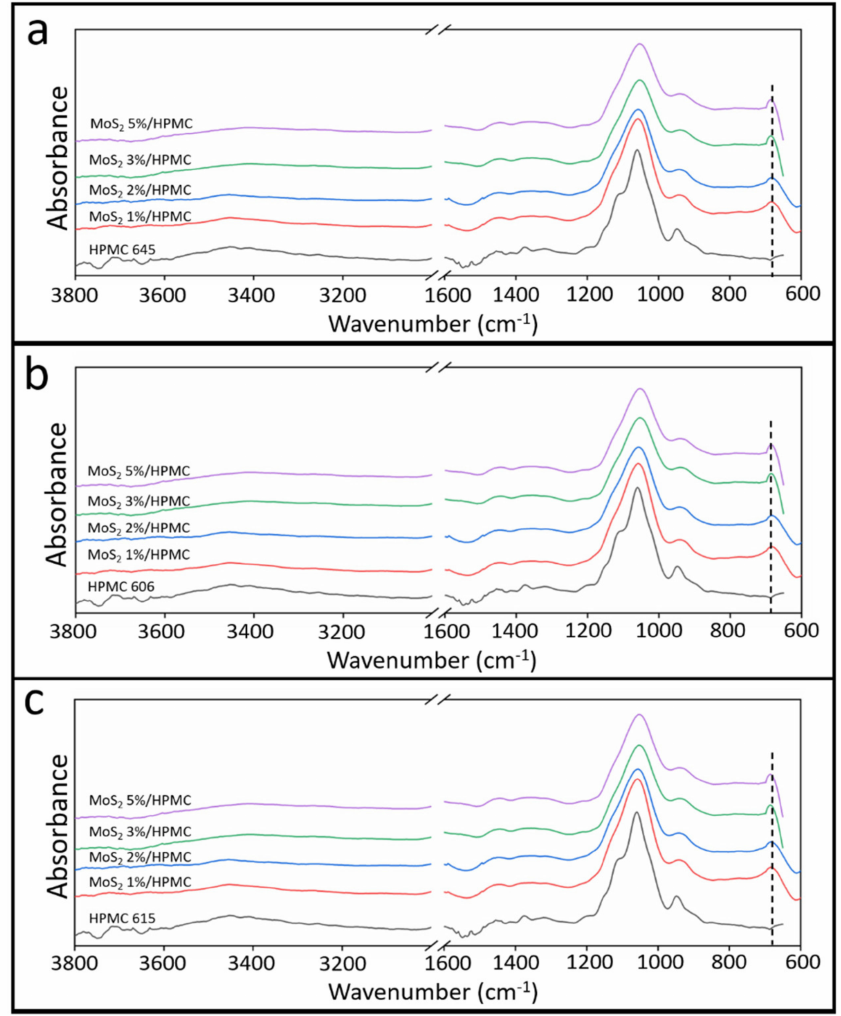
Figure 6. Fourier transform infrared (FTIR) spectra of hydroxypropyl methylcellulose (HPMC): ( a ) 645 composites; ( b ) 606 composites; and ( c ) 615